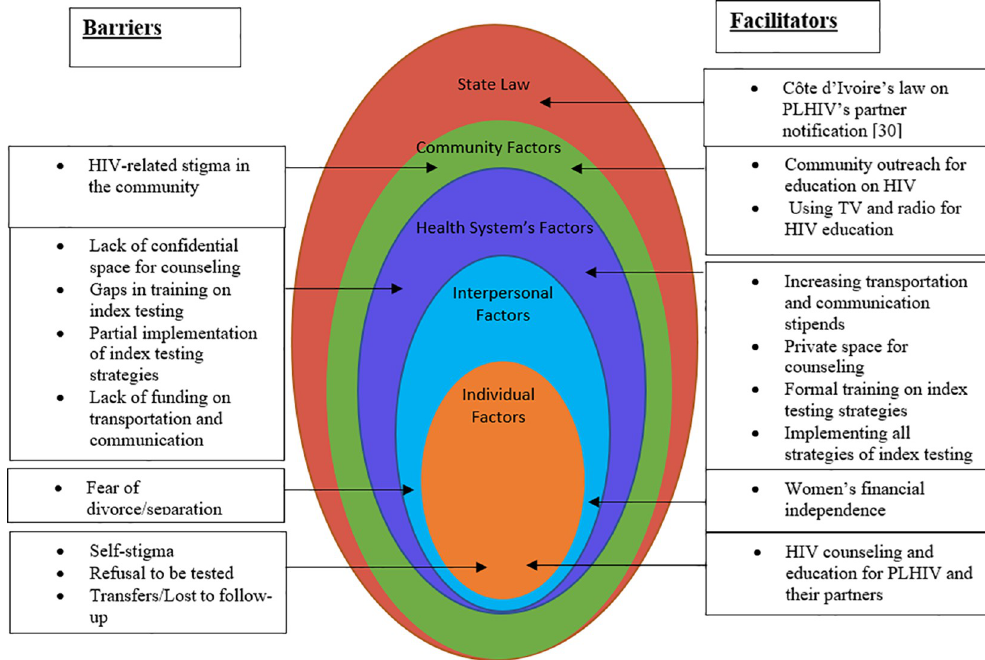
Fig 5. Barriers and facilitators of index testing. Summary of index testing barriers and proposed solutions (facilitators) using a socio-ecological model.